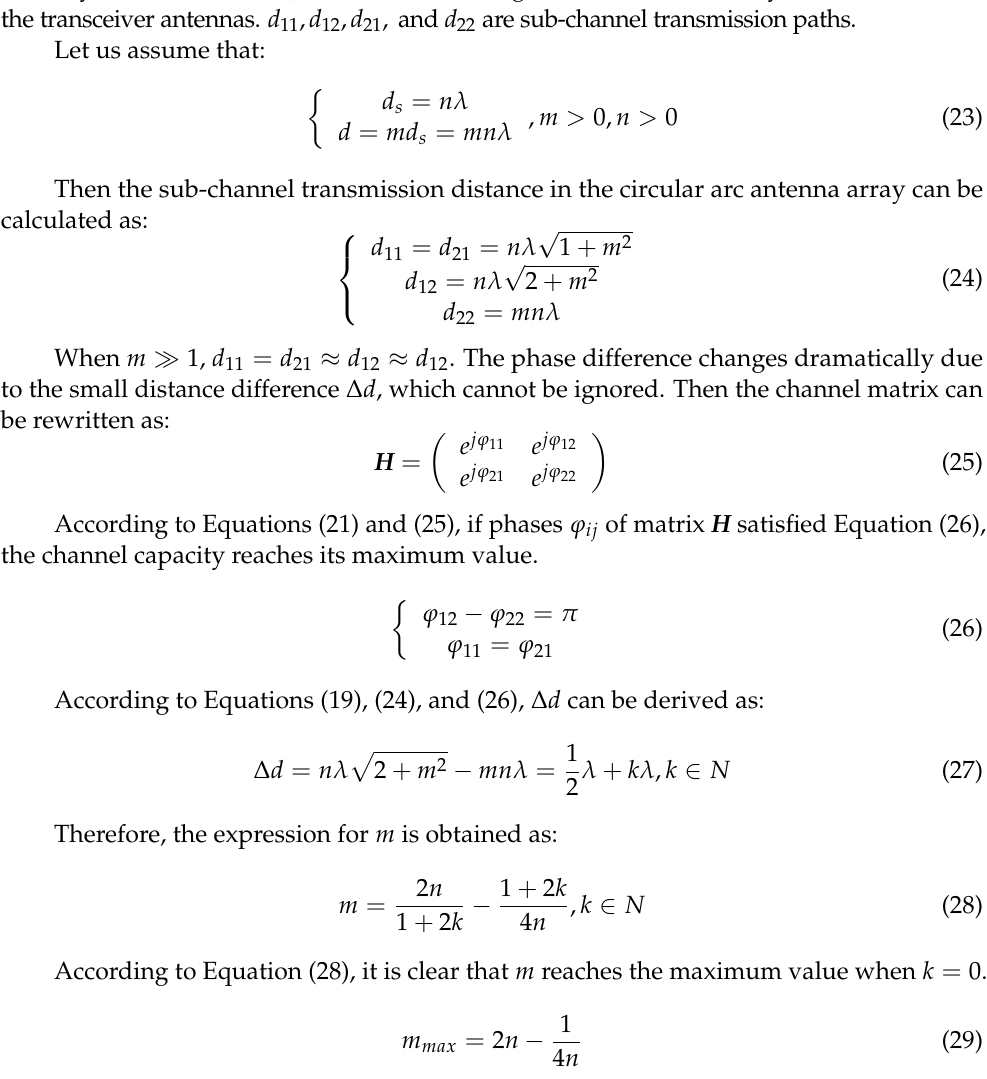
the distance of the transceiver antennas. 𝑑 (cid:2869)(cid:2869) , 𝑑 (cid:2869)(cid:2870) , 𝑑 (cid:2870)(cid:2869) , and 𝑑 (cid:2870)(cid:2870) are sub-channel transmis- sion paths.